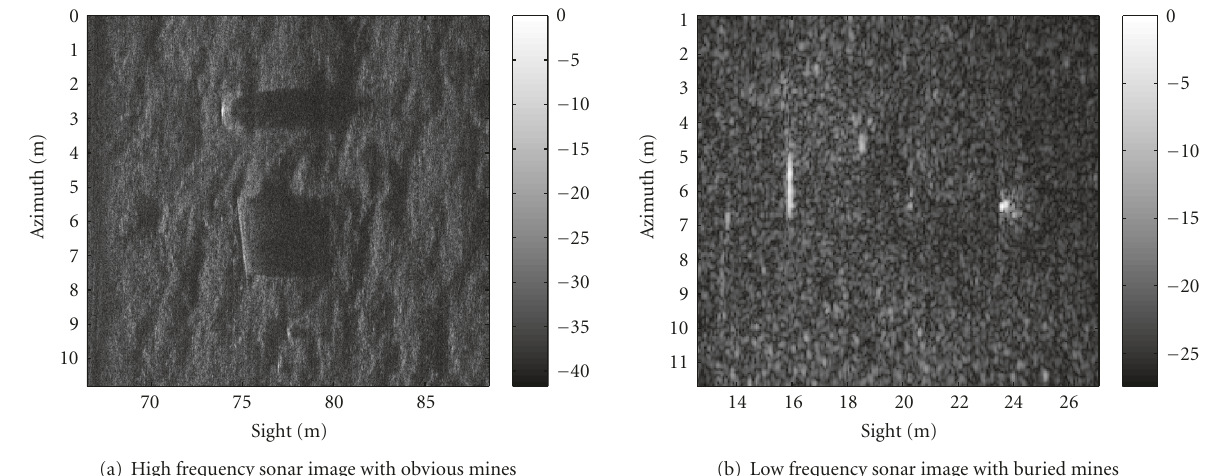
Figure 1: Example of sonar images (SAS, normalized dB